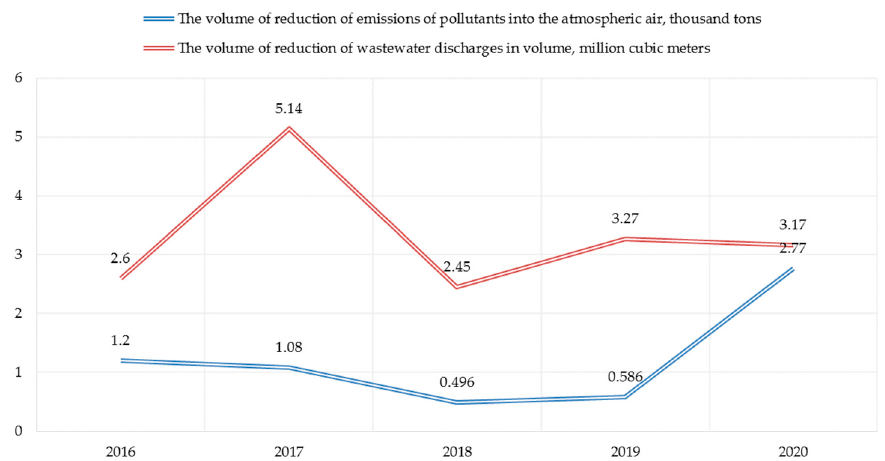
Figure 2. Dynamics of reducing the negative impact of the enterprise’s activities on the environment.